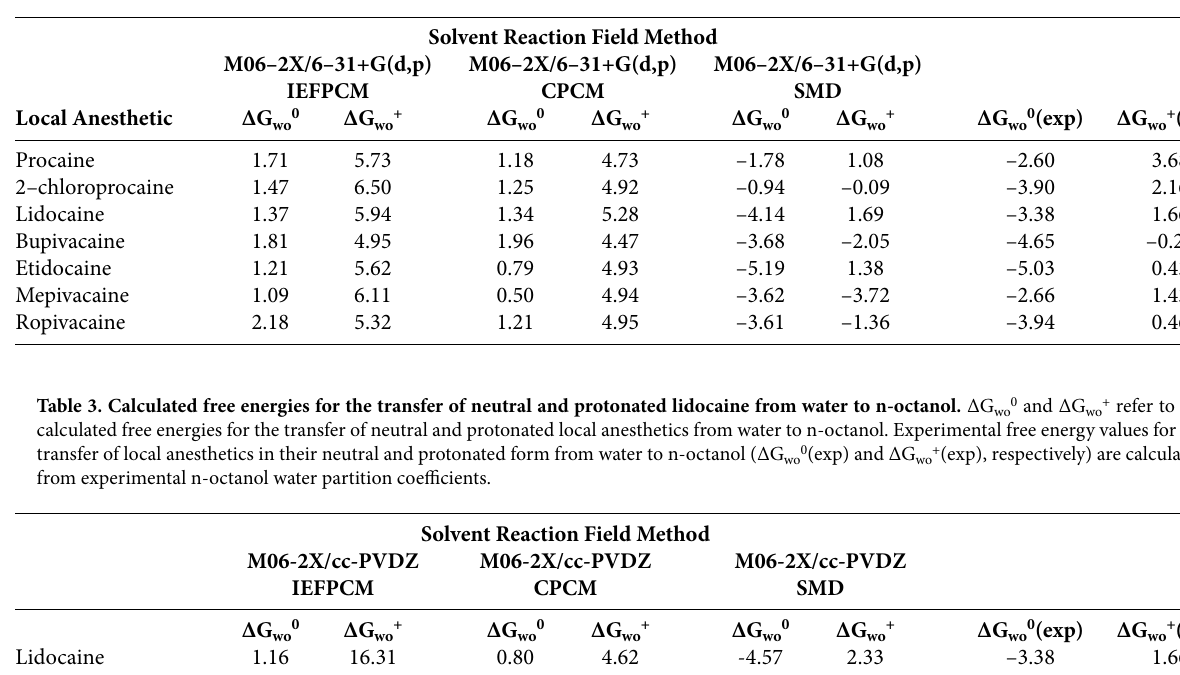
Table 2. Calculated free energies for the transfer of neutral and protonated local anesthetics from water to n–octanol. Three solvent reaction field methods were used. ΔG wo0 and ΔG wo+ refer to the calculated free energies for the transfer of neutral and protonated local anesthetics from water to n–octanol. Experimental free energy values for the transfer of local anesthetics in their neutral and protonated form from water to n–oc- tanol (ΔG wo0 (exp) and ΔG wo+ (exp), respectively) are calculated from the experimental n–octanol/water partition coefficients.(6) All values are given in kcal mol –1